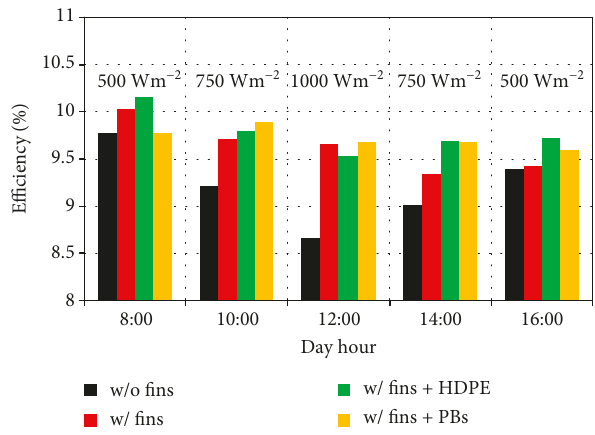
Figure 7: Measure e ffi ciencies of the PV panel with no fi ns, fi ns, fi ns +HDPE, and fi